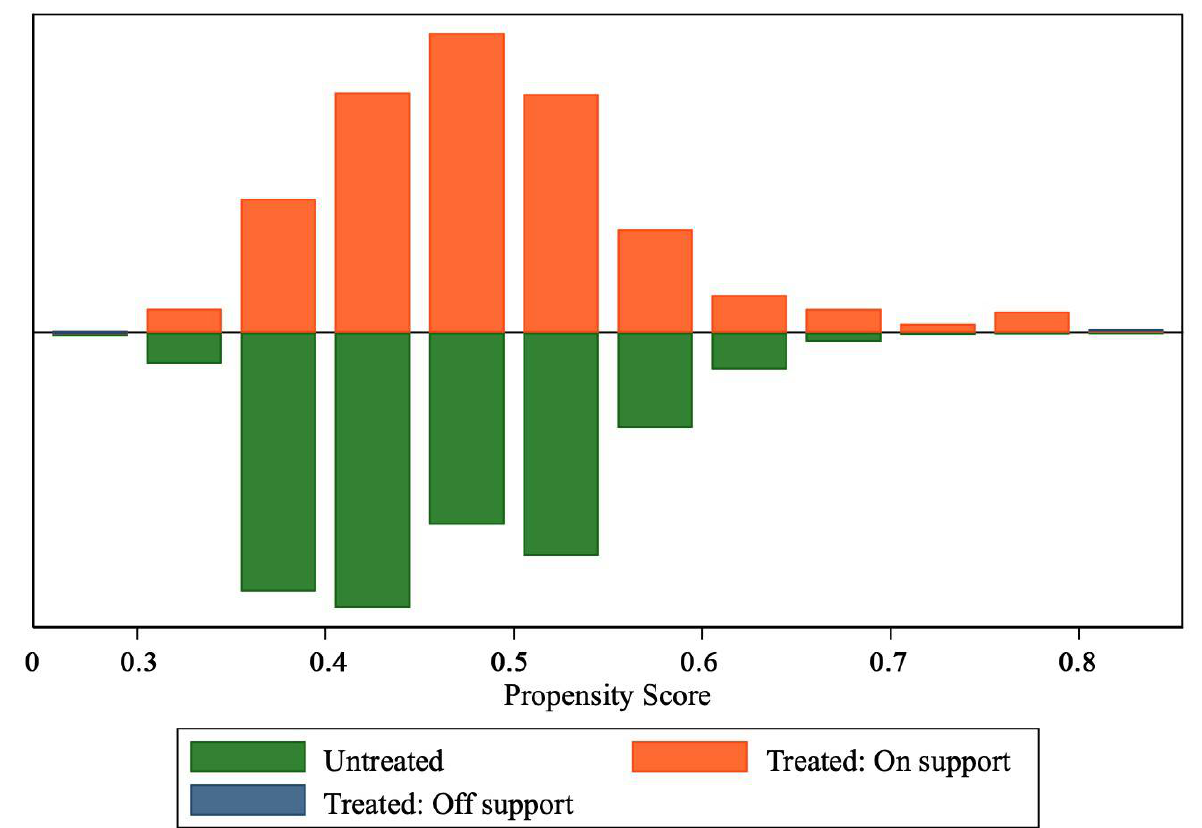
Figure 3. Common support hypothesis test results for PSM.